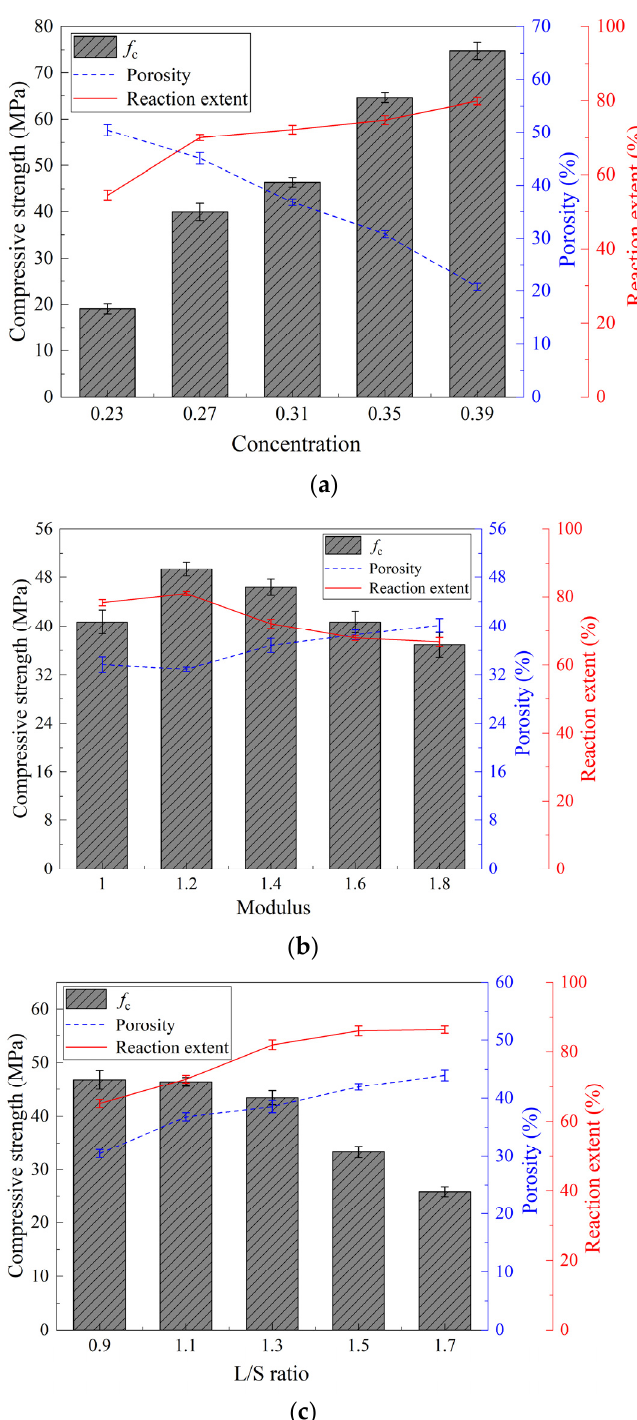
Figure 9. Compressive strength as a function of reaction extent and porosity: concentrations ( a ), moduli ( b ), and L/S ratios ( c ).